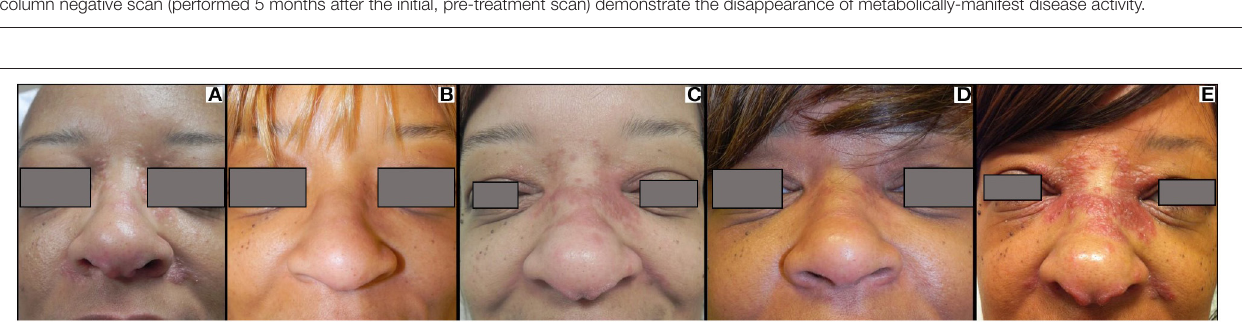
FIGURE 6 | Recurrent cutaneous sarcoidosis. This patient has extensive papular sarcoidosis of the medial canthus, nose, and melo-labial crease (A) . Her disease initially cleared with hydroxychloroquine and minocycline therapy (B) . She experienced disease recurrence (C) , and after failing to respond to methotrexate, was treated with infliximab with clearance (D) . When her infliximab was stopped, she exhibited recurrence in a similar distribution with minimal local direct extension (E). She has since cleared again on infliximab (not